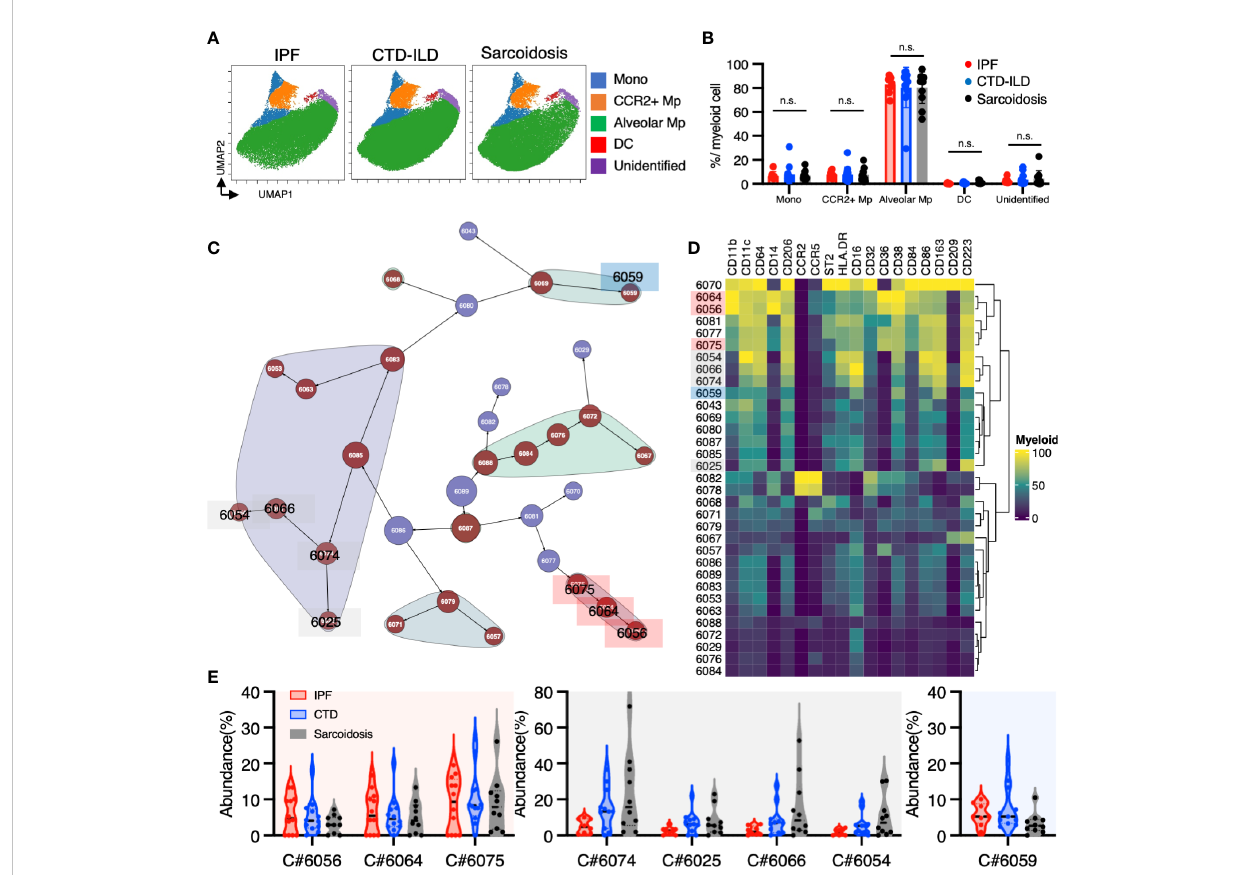
FIGURE 2 Characterization of myeloid cell subsets in BALF from patients with IPF, CTD-ILD, and sarcoidosis. (A) UMAP plots of concatenated samples visualizing the distribution of CD11b + CD11c + myeloid cell subpopulations in BALF from patients with IPF, CTD-ILD, and sarcoidosis. Monocytes are de fi ned by CD64 + CD14 + , CCR2 + macrophages (Mp) by CCR2 + CD64 + CD14 – , Alveolar Mp by CD64 + CD206 + , dendritic cells (DC) by CD64 – CD206 – CD11c + HLA- DR + , unidenti fi ed cells by CD64 – CD206 – CD11c lo HLA-DR – . (B) The proportions of myeloid cell subpopulations in IPF, CTD-ILD, and sarcoidosis. Graphical plots represent individual samples. Statistical differences were analyzed by two-way ANOVA followed by Tukey ’ s multiple comparison test. n.s. not signi fi cant. (C) Citrus network tree visualizing the hierarchical relationship and intensity of each marker between identi fi ed myeloid cell populations gated by CD45 + CD11b + CD11c + from IPF (n = 8), CTD-ILD (n = 11), and sarcoidosis (n = 10). Clusters with signi fi cant differences were represented in red, and those without signi fi cant differences in blue. Circle size re fl ects the number of cells within a given cluster. (D) Heatmap illustrating the expression markers across different clusters of myeloid cells as determined by the Citrus analysis. (E) Citrus-generated violin plots for eight representative and differentially regulated populations. Each cluster number (C#) corresponds to the number shown in panel (C) . All differences in abundance were signi fi cant at a false discovery rate <